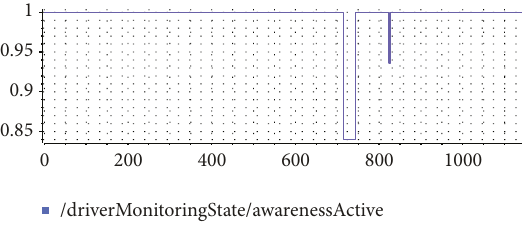
Figure 28: T1D6 driver awareness.